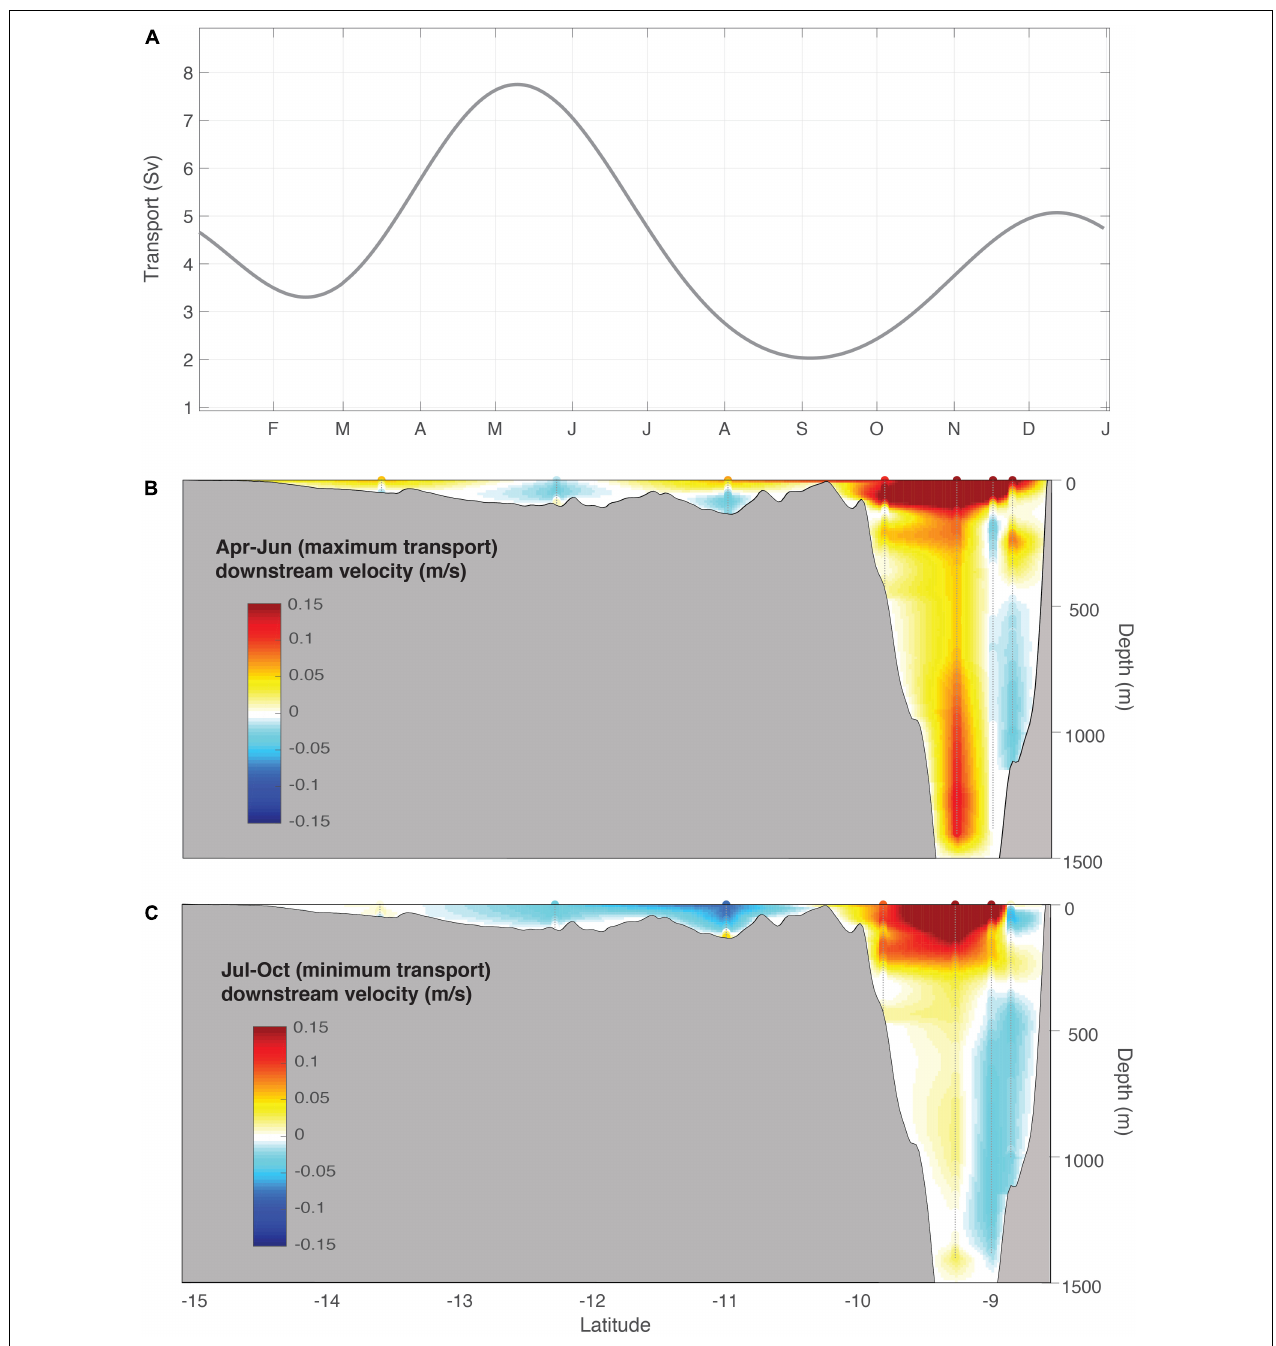
FIGURE 7 | Timor Passage and extension to northern Australian continental shelf IMOS moorings (2011–2015) (A) seasonal transport (Sv), mean velocity (m/s) section for (B) April–June and (C) July–October. April–June corresponds to maximum net transport and July–October to minimum net transport. Vertical lines indicate the position of the